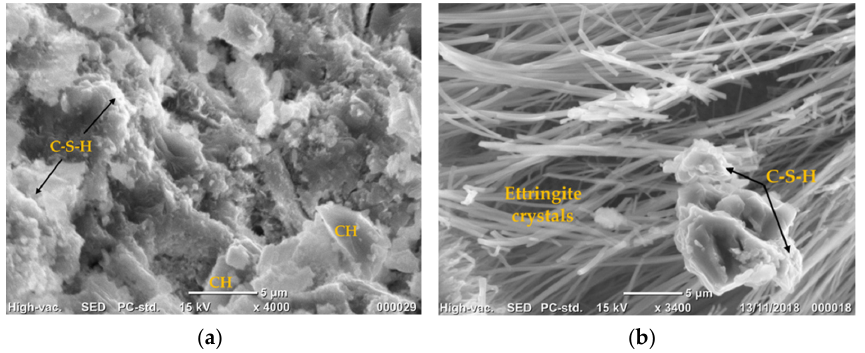
Figure 10. SEM observations of the reference mix ( a ) and the ternary binders based on GGBS and FCS ( b ) after 90 days of curing.